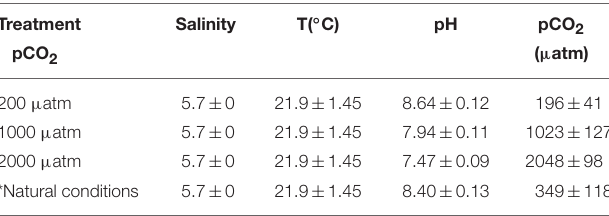
TABLE 2 | Environmental variables (salinity and temperature) and carbonate parameters pCO 2 ( n = 11) and pH NBS ( n = 11) in different treatments measured during the experimental period in 2014.